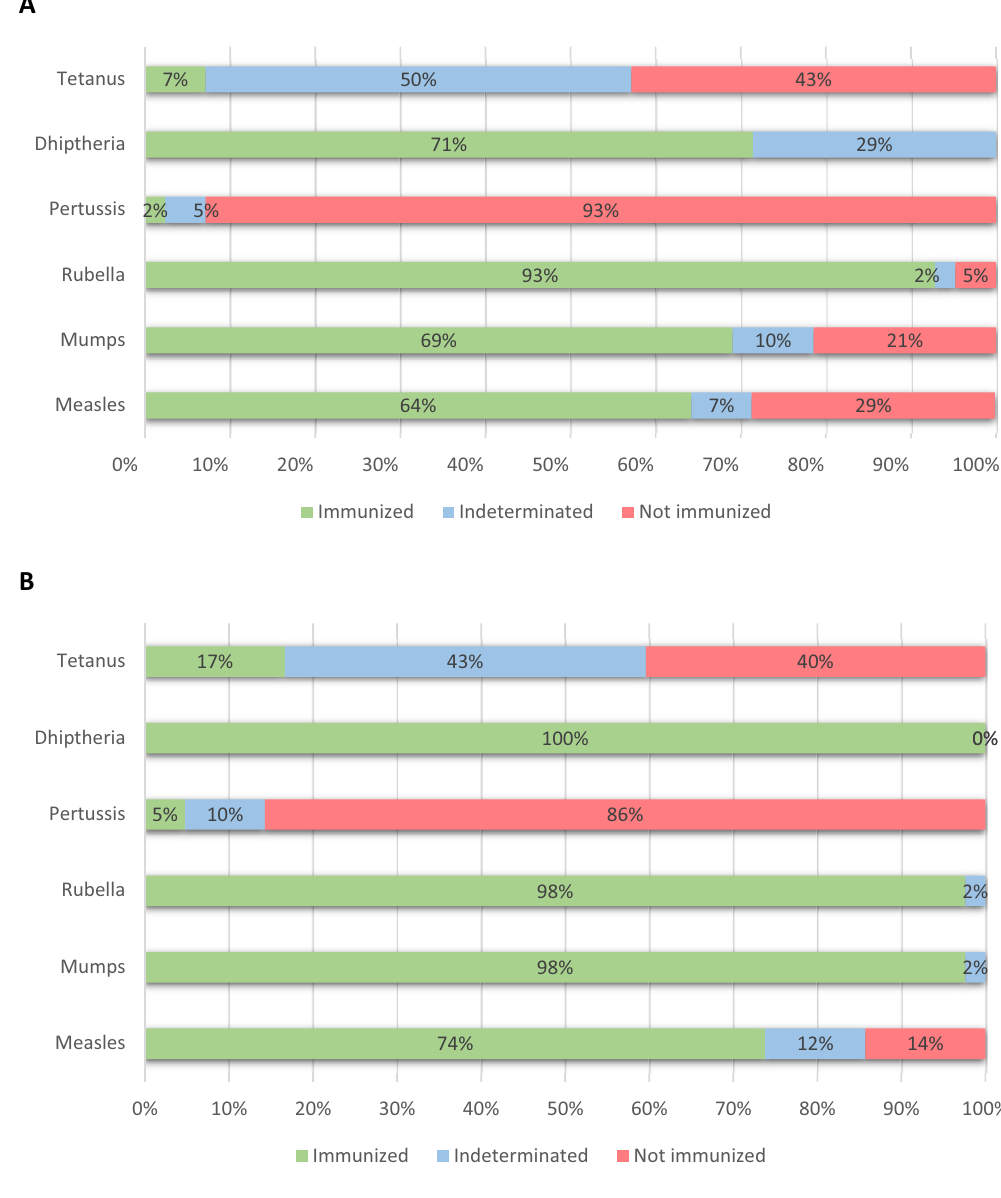
Figure 1. Pathogen immunity in 42 paediatric and adolescents from Kinshasa with available plasma ( A ) or DBS ( B ) considering the VIRCELL